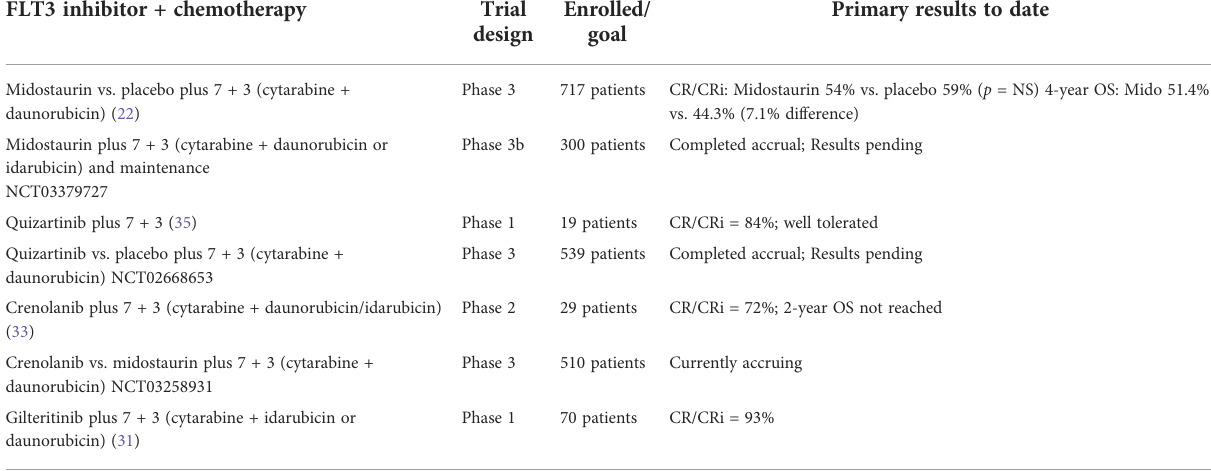
TABLE 3 FLT3 inhibitors combined with intensive chemotherapy in frontline AML therapy: clinical trials. FLT3 inhibitor +